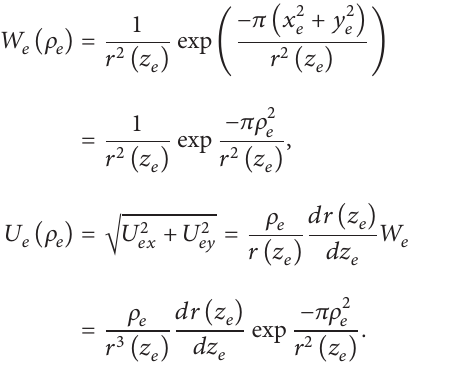
Figure 2: Integral domain in pile driving.